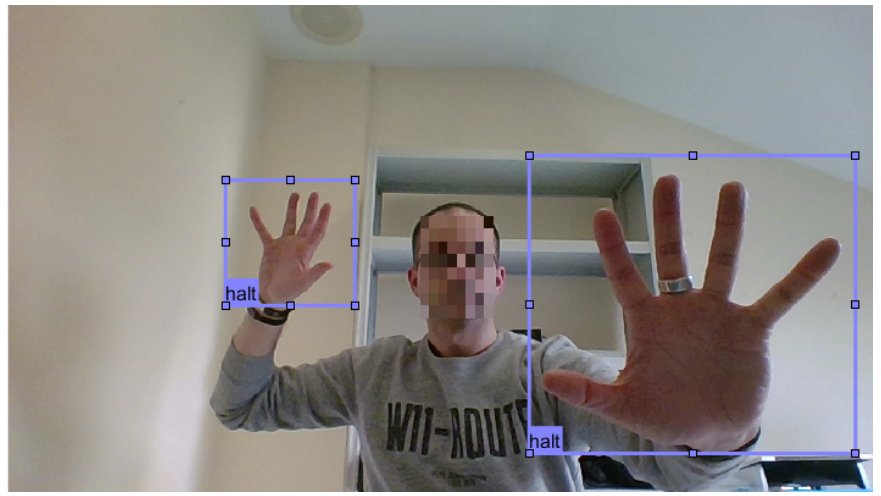
Figure 4. Image for the Halt gesture.